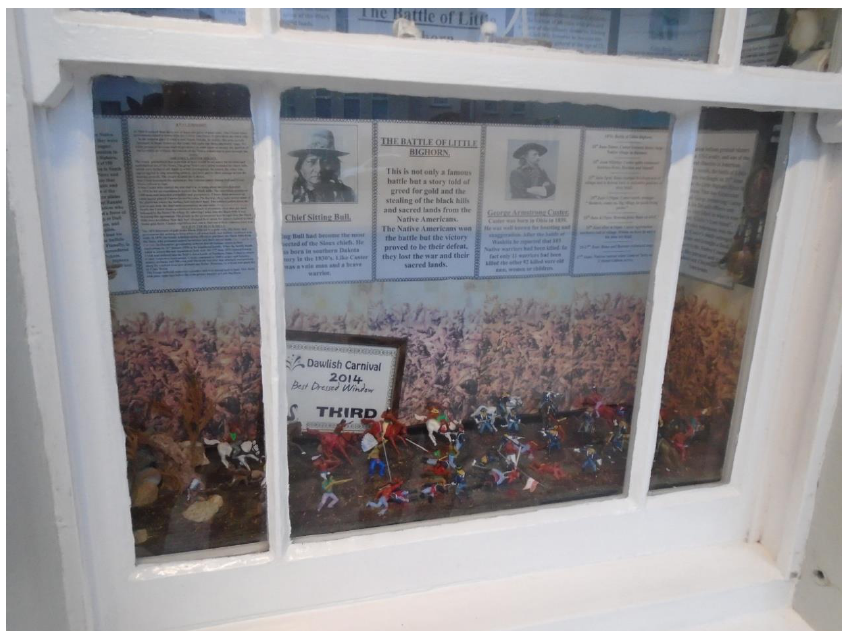
Figure 32. Display in window of café.